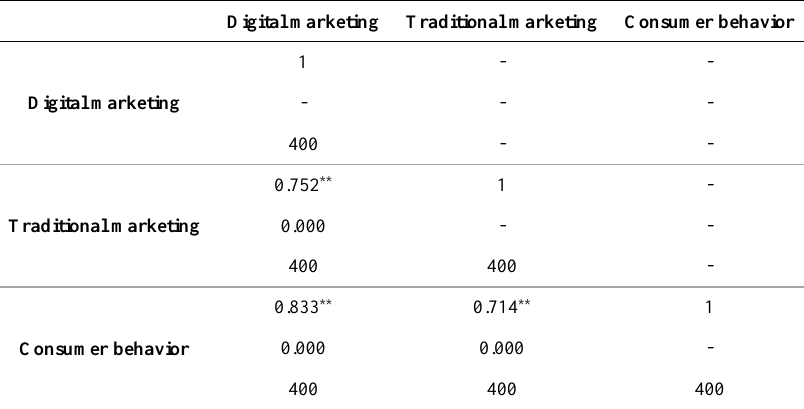
Table 4. Correlation matrix